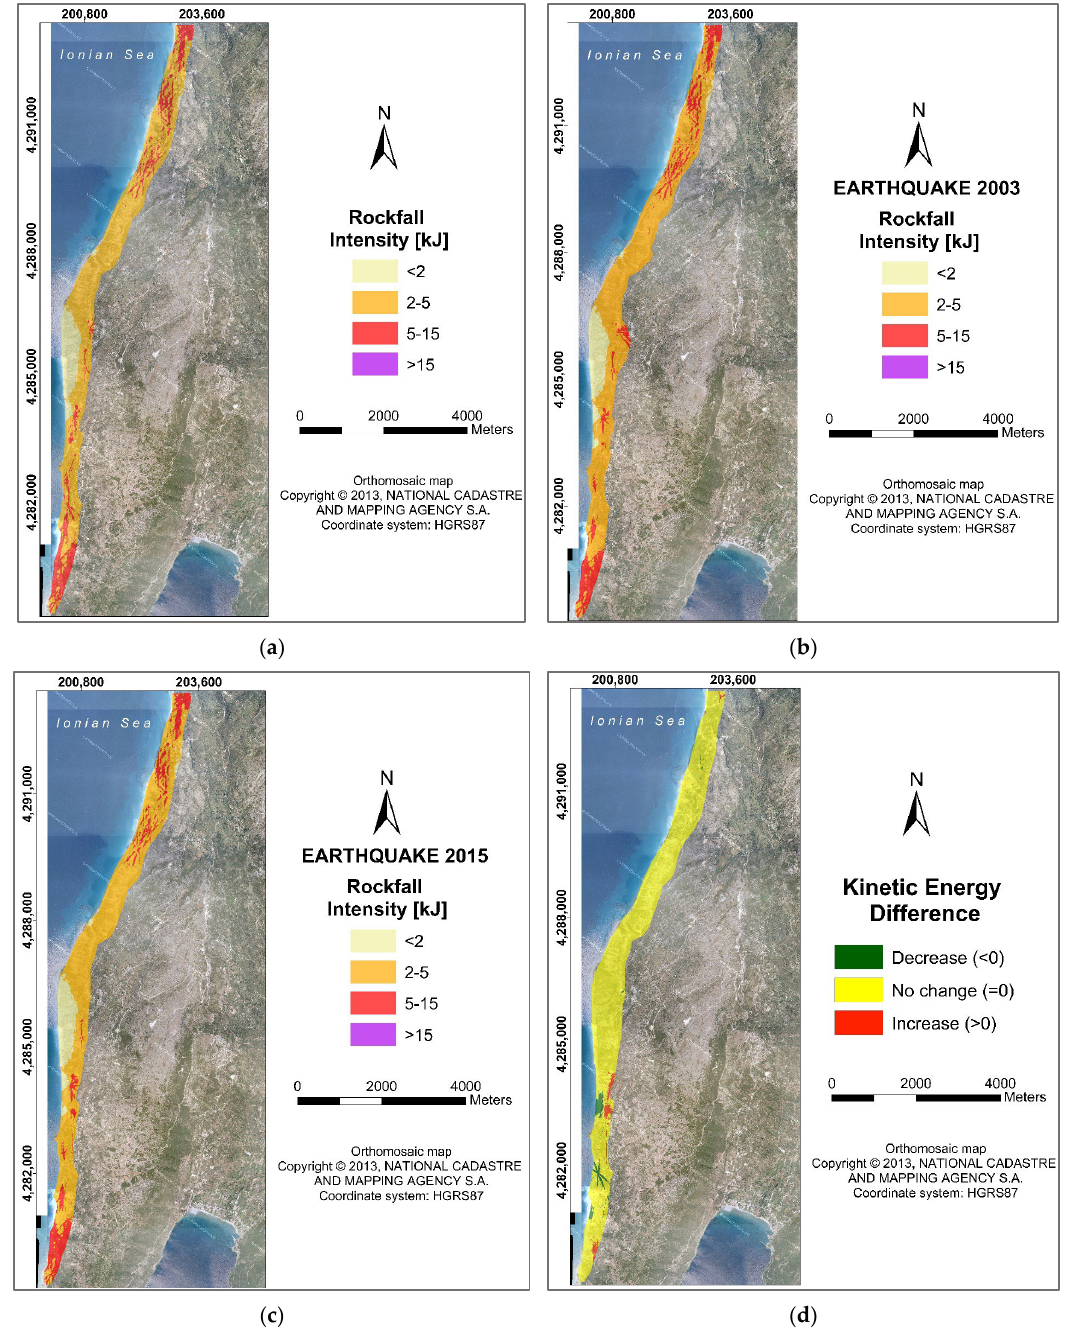
Figure 12. Rockfall intensity maps of area C, with ( a ) Vo = 0, ( b ) Vo = 0.57 m/s, ( c ) Vo = 1.18 m/s, and ( d ) difference in the kinetic energy distribution between ( a and c ).